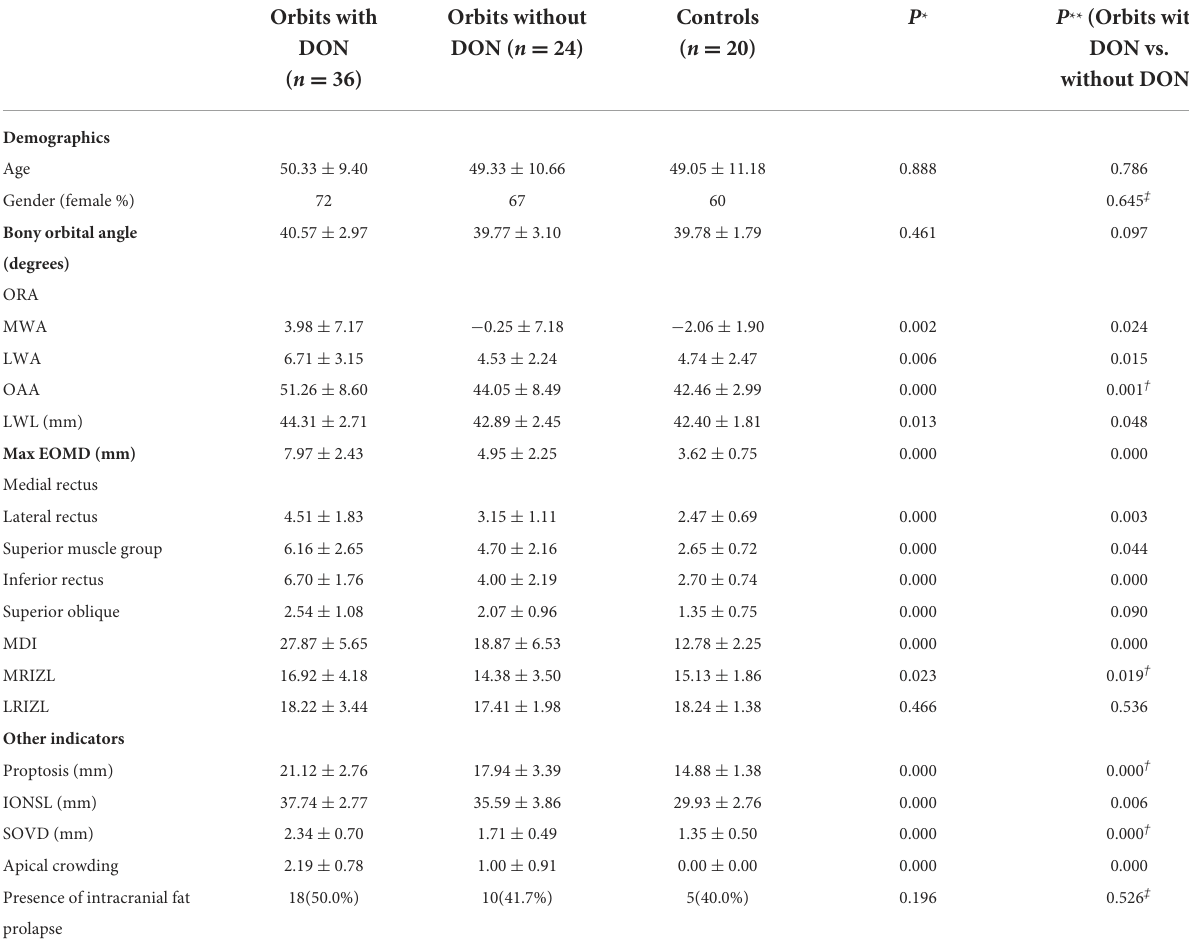
TABLE 1 Comparison of demographics, bony orbit, and soft tissue structures in three groups.